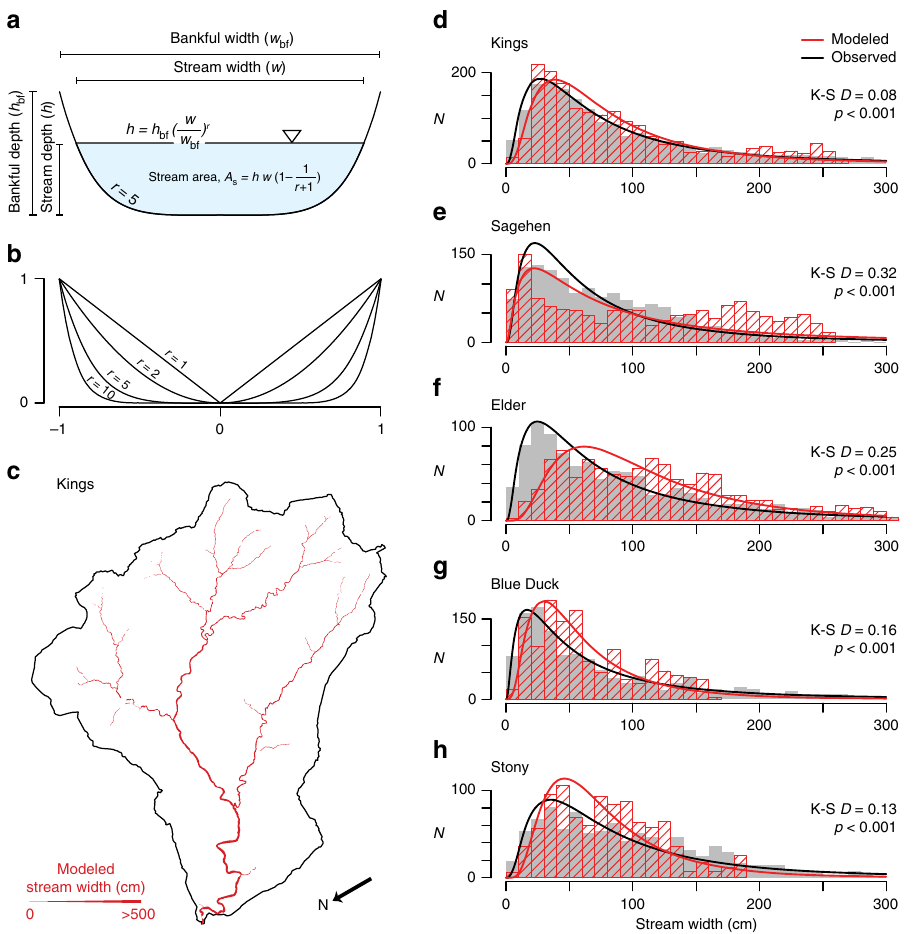
Fig. 4 Origin of the lognormal stream width distribution. a Schematic channel cross section; b schematic relationship between the shape parameter, r , and channel cross-sectional shape; c map of modeled stream widths in example study catchment. Length of north arrow is 200 m. d – h The distribution of modeled stream widths compared to fi eld observations. N : measurement frequency. K – S D : Kolmogorov – Smirnov test statistic. p : calculated